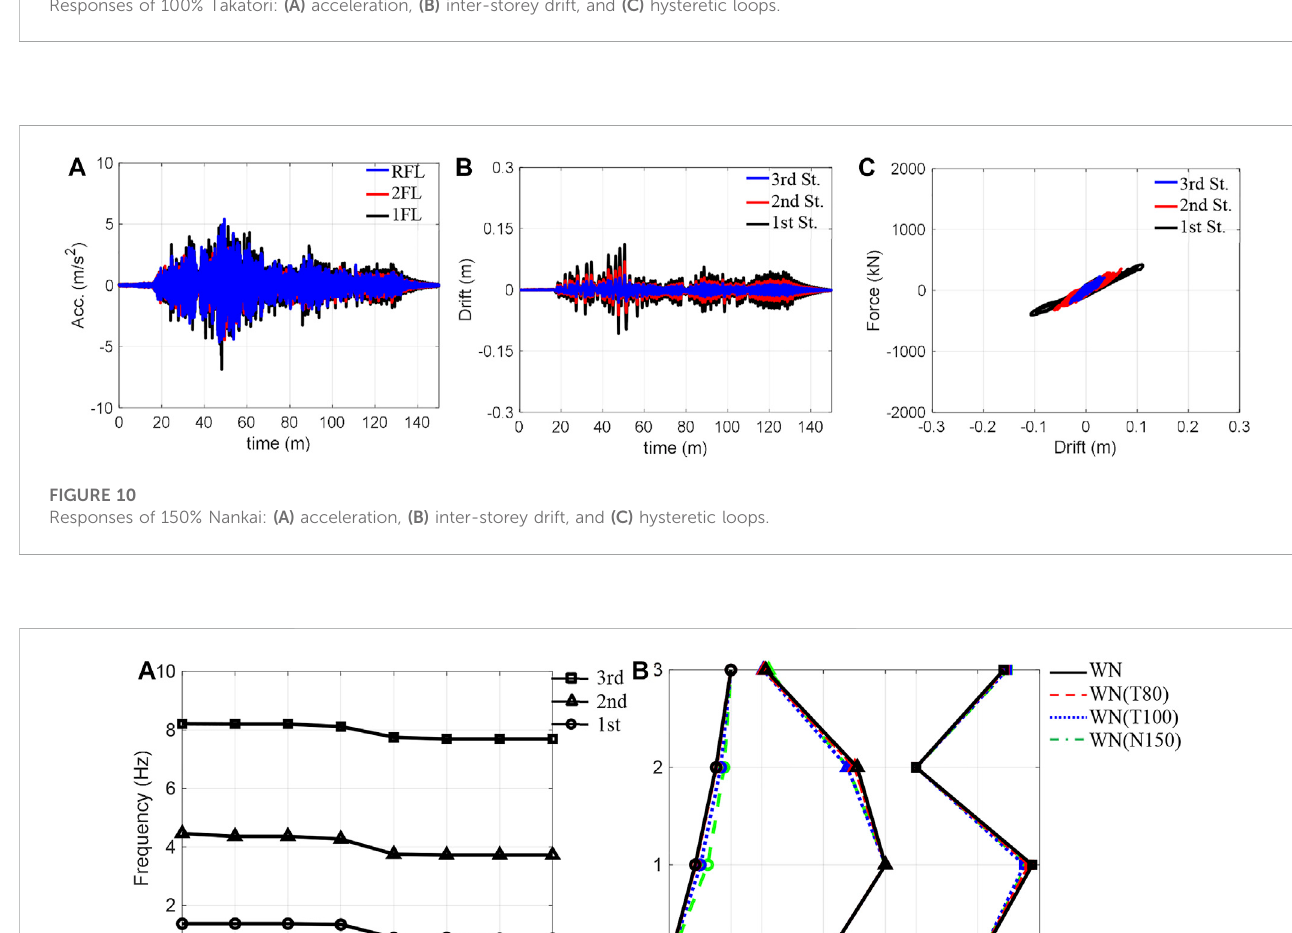
FIGURE 9 Responses of 100% Takatori: (A) acceleration, (B) inter-storey drift, and (C) hysteretic loops.